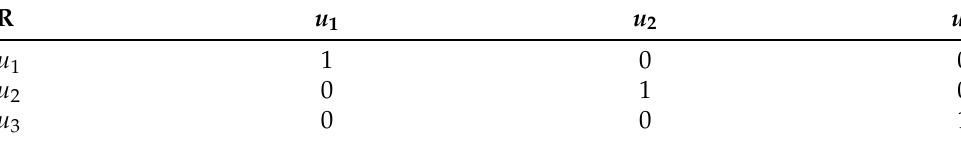
Table 2. The L -valued relation R in Example